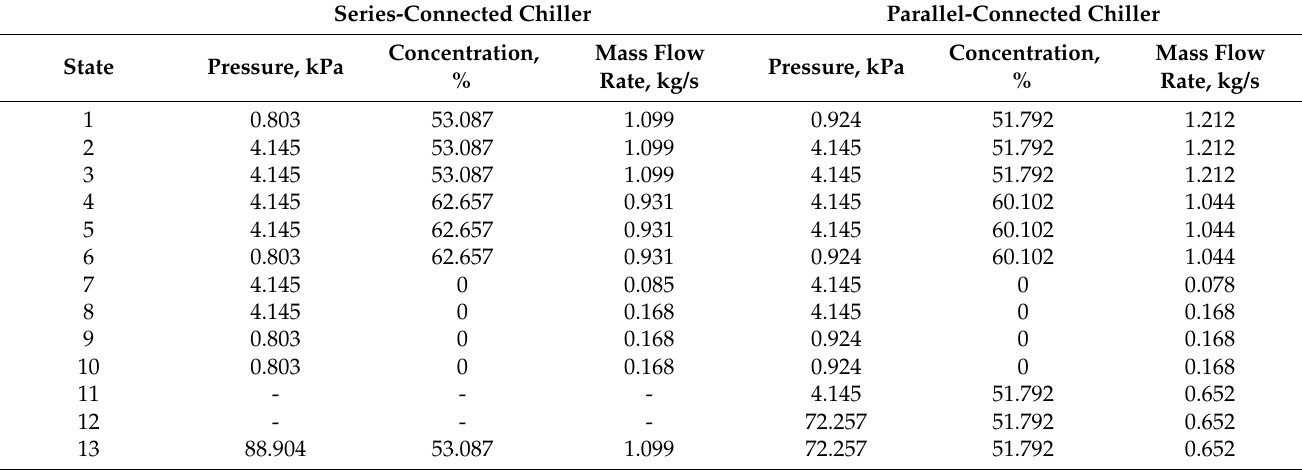
Table A1. Simulation results of states for two chiller